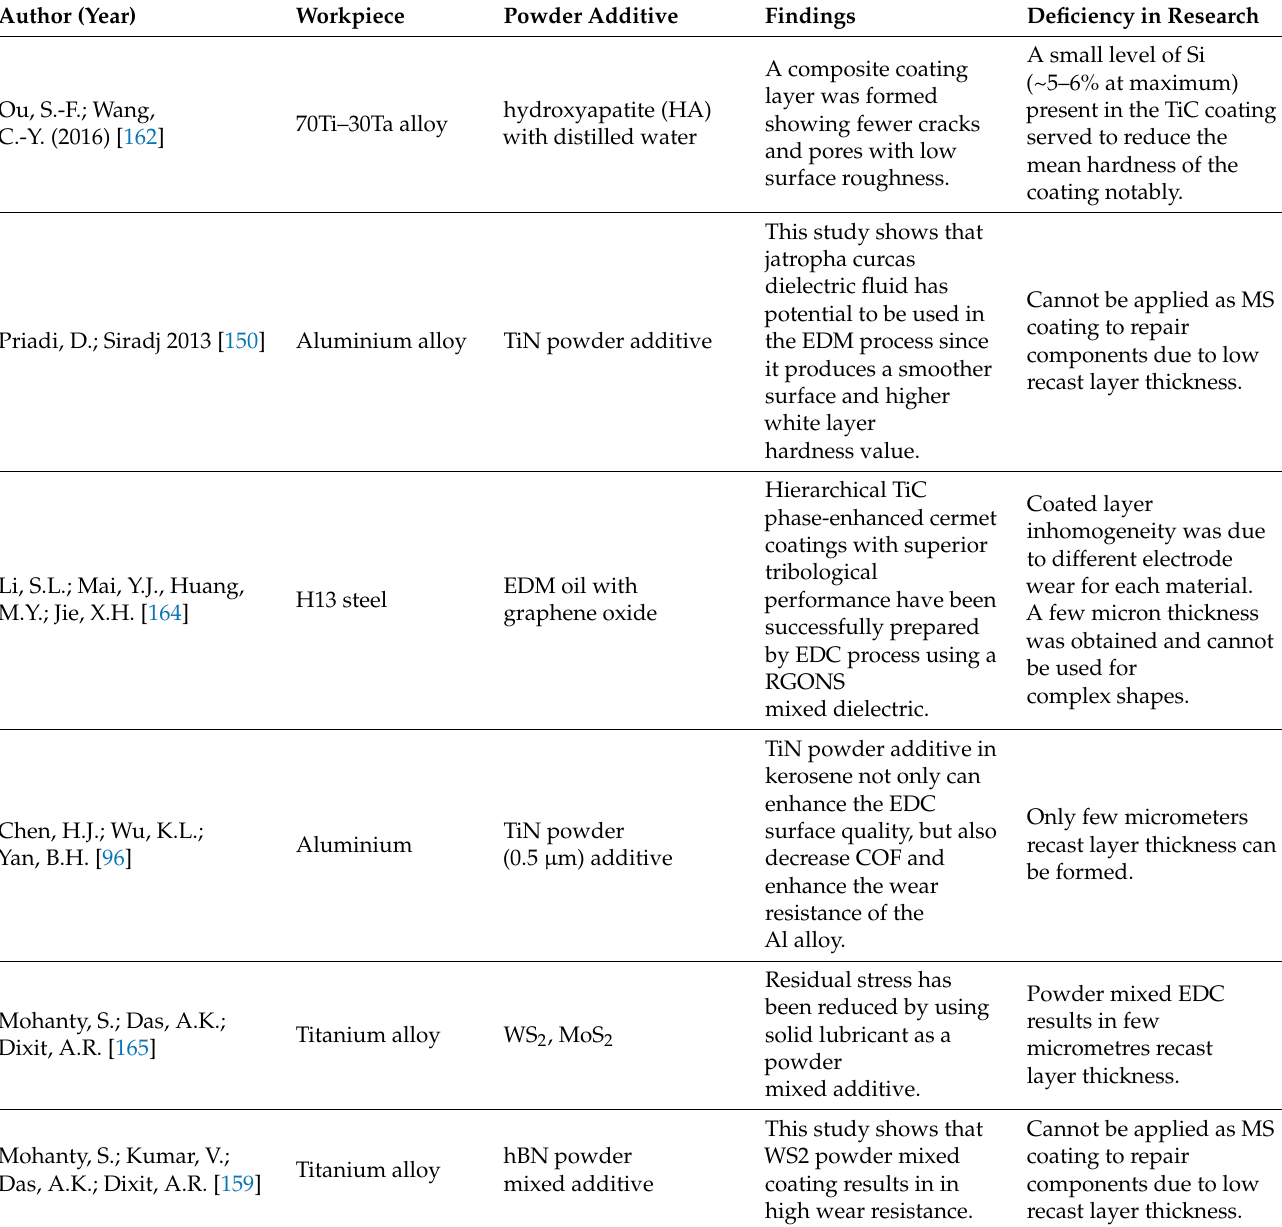
Table 8. Summary of past literature work on EDC with powder mixed